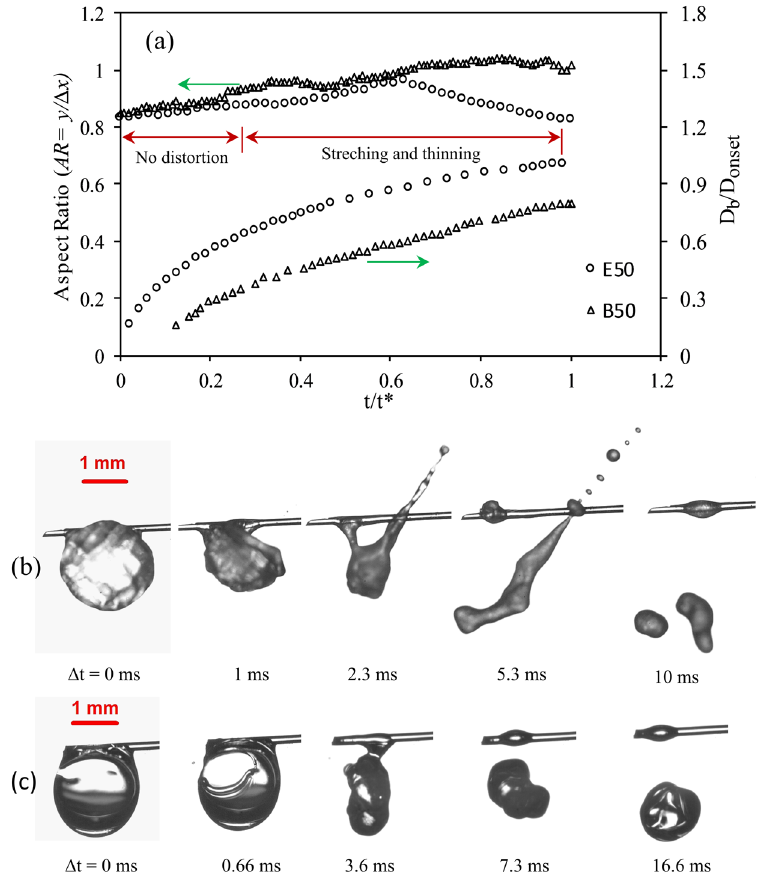
Figure 11. ( a ) Temporal evolution of droplet aspect ratio and bubble diameter during the bubble growth in E50 and B50 blended droplets. The typical breakup of ( b ) E50 droplet with low aspect ratio (AR = 0.95) and ( c ) B50 droplet with high aspect ratio (AR =